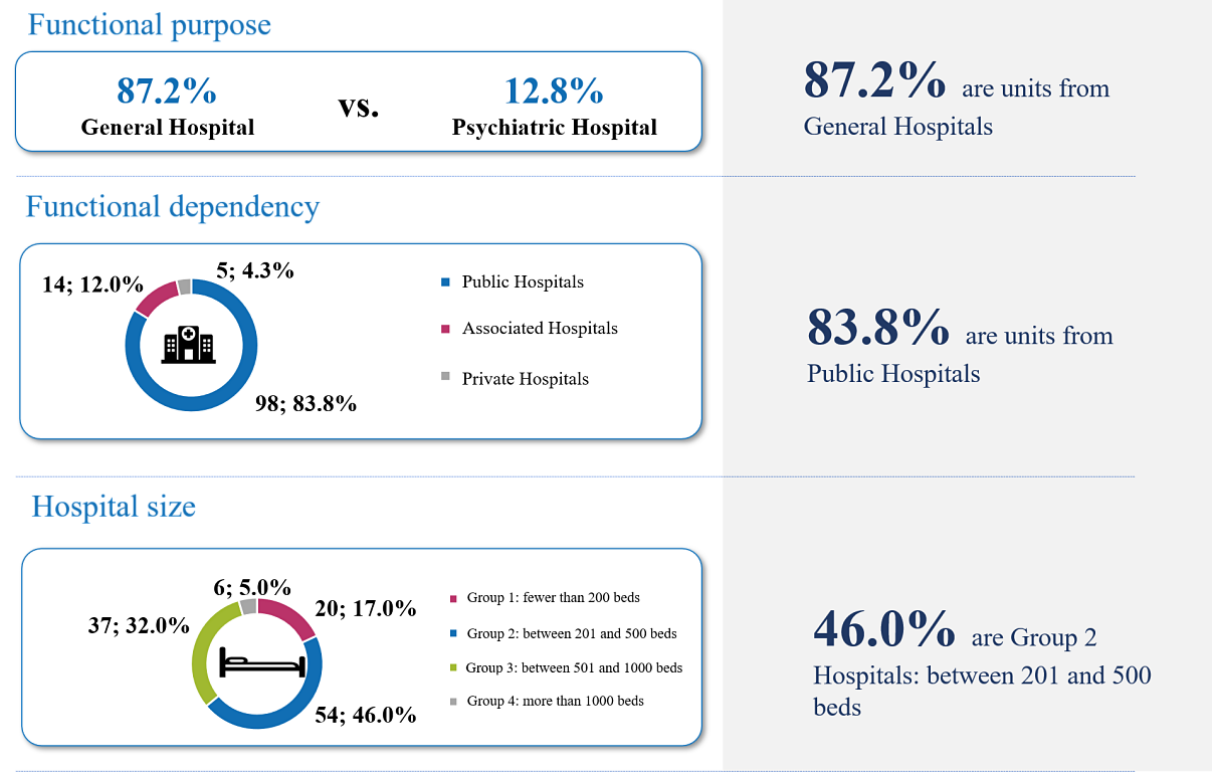
Figure 2. Profile of the units that completed the acute inpatient psychiatric unit (AIPU)